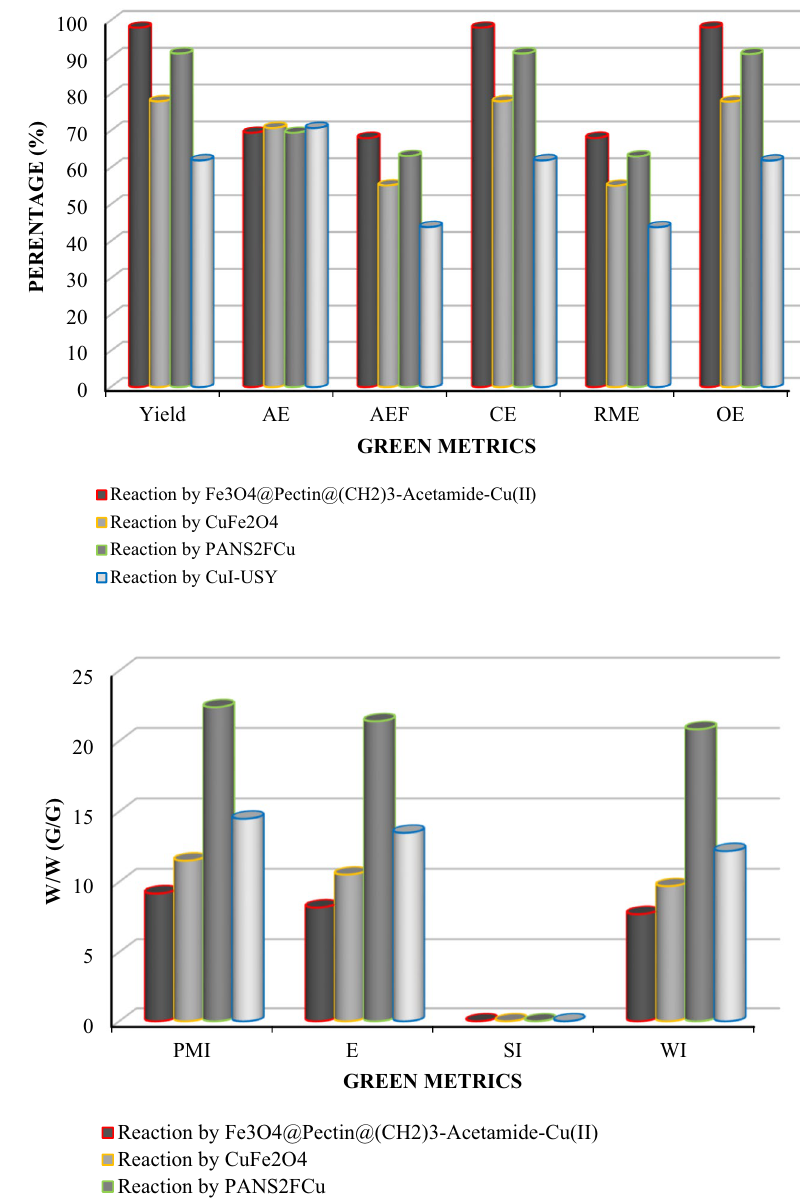
Figure 14. Green metrics including ( a ) AE, AEf, CE, RME, OE and ( b ) PMI, E, SI and WI for the one-pot Multi-component reaction of Phenacyl bromide, sodium azide, phenylacetylene, and catalysed by Fe 3 O 4 @ Pectin@(CH 2 ) 3 -Acetamide-Cu(II) (this study), CuFe 2 O 4 (Table 3, entry 2), PAN S2 FCu (Table 3, entry 3) and CuI-USY (Table 3, entry 7); W/W = Weight/Weight